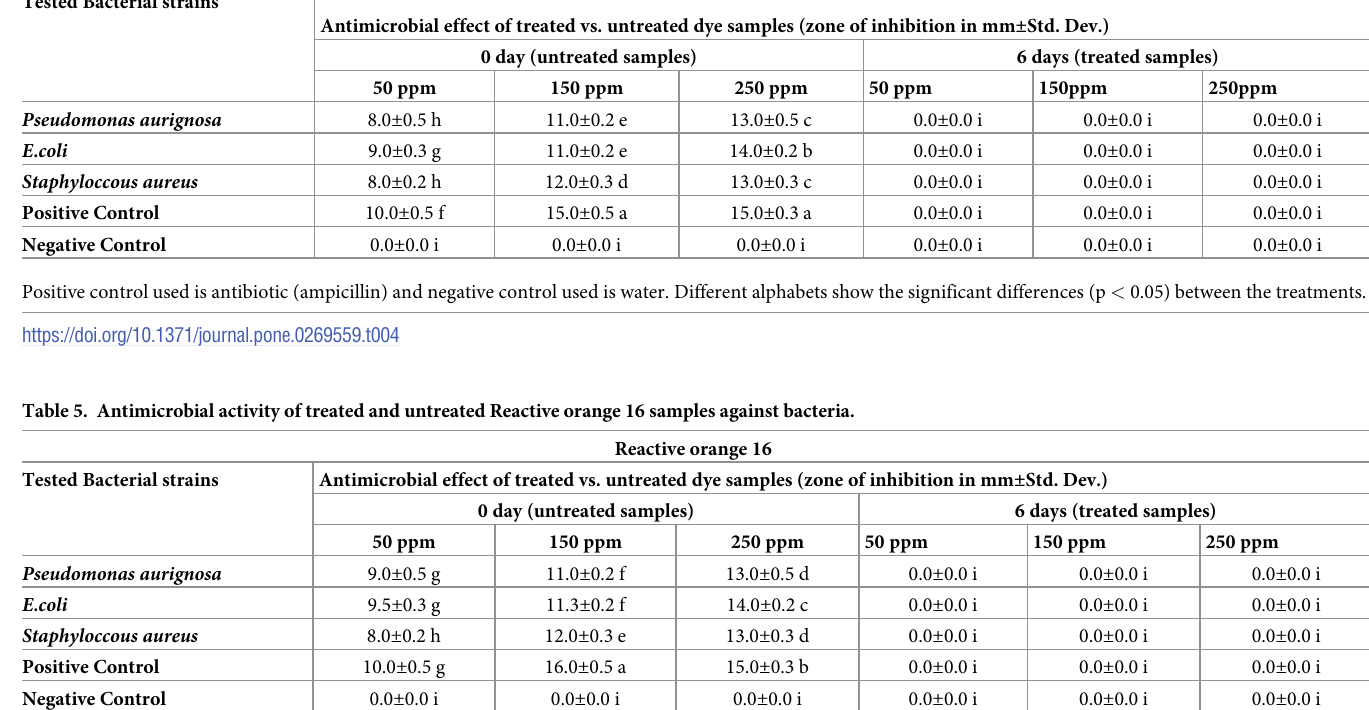
Reactive Black 5